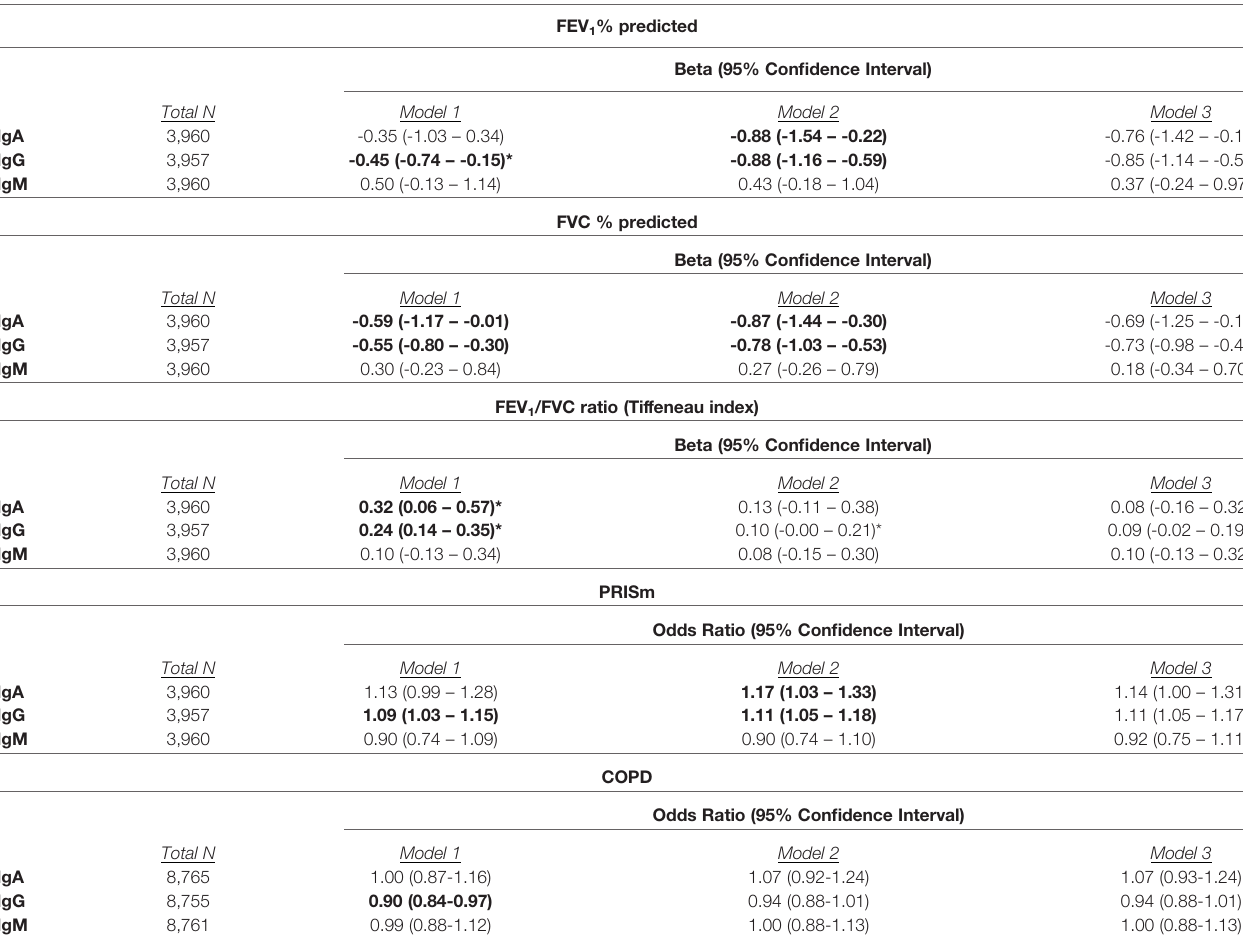
TABLE 5 | Association between serum immunoglobulins and lung function values or spirometry